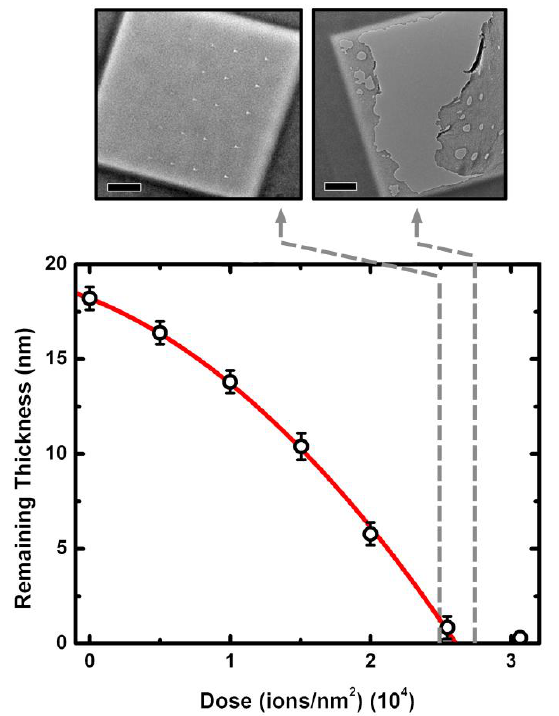
Figure 2. Membrane thinning analysis. Relationship between total He+ ion dose and remaining thickness of a SiN membrane (initial thickness 18.2 nm), as determined by transmission Helium ion analysis. Solid line is a second-order polynomial fit to the data. Each dashed arrow leads to a transmission electron micrograph of a 500 nm × 500 nm patterned region milled with the indicated dose (2.50 ( L ) and 2.75 ( R ) ×10 4 ions/nm 2 ). A dot array is formed within the pattern as a marker to indicate whether the local membrane remains. Scale bars are 100